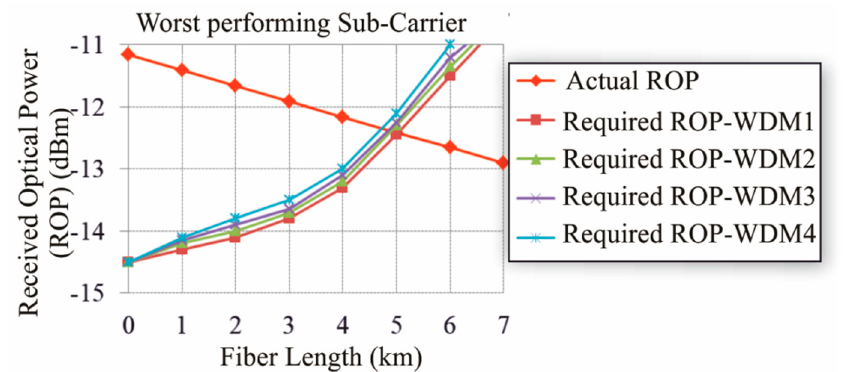
Figure 11. ROP versus the length of the fiber connecting the BBU with the first ROADM. Curve of the actual ROP deriving from the power budget of the hotspot link and curves of the ROP required to achieve an EVM = 8% for all WDM channels.